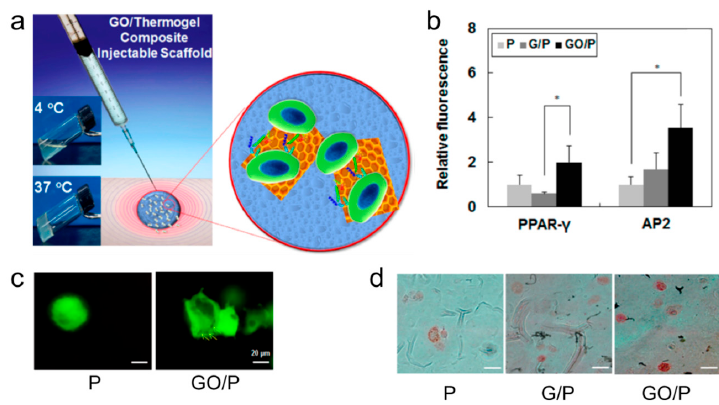
Figure 12. ( a ) Schematic presentation of the 3D culture of TMSCs in a GO/P composite injectable system; ( b ) Semiquantitative analysis of the fluorescence images, * indicates p < 0.05 by Student t -test; ( c ) Comparative images of a thermogel (P) system, and graphene oxide-incorporated thermogel (GO/P) system at day 14. The arrows in the GO/P system image indicate lipid vesicles. The scale bar is 20 µ